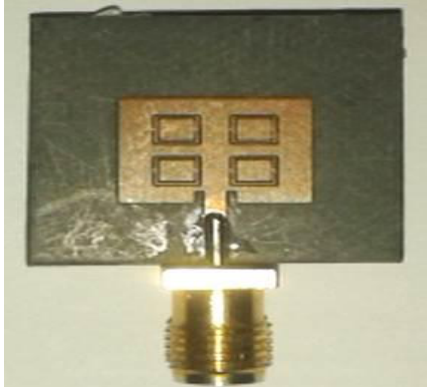
Figure 7: Dual-band antenna with three CSRR cell.